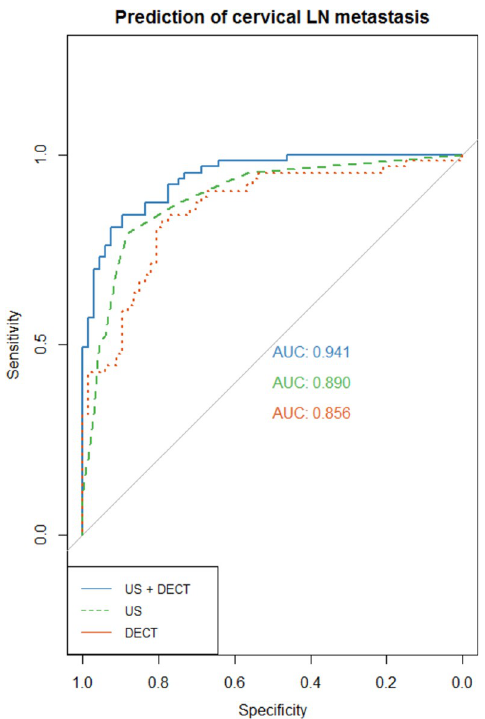
Fig 3. Receiver operating characteristic curves for diagnostic performance in predicting metastatic LNs based on DECT parameters alone (HU arterial , IC, CM, Z eff , AUC 100keV ) and in combination with suspicious features on US (hyperechogenicity, round shape, cystic